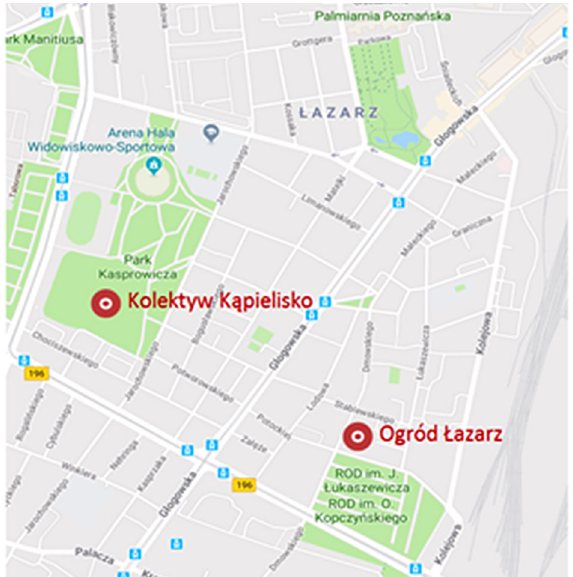
Fig. 5. Community gardens in the Łazarz district .